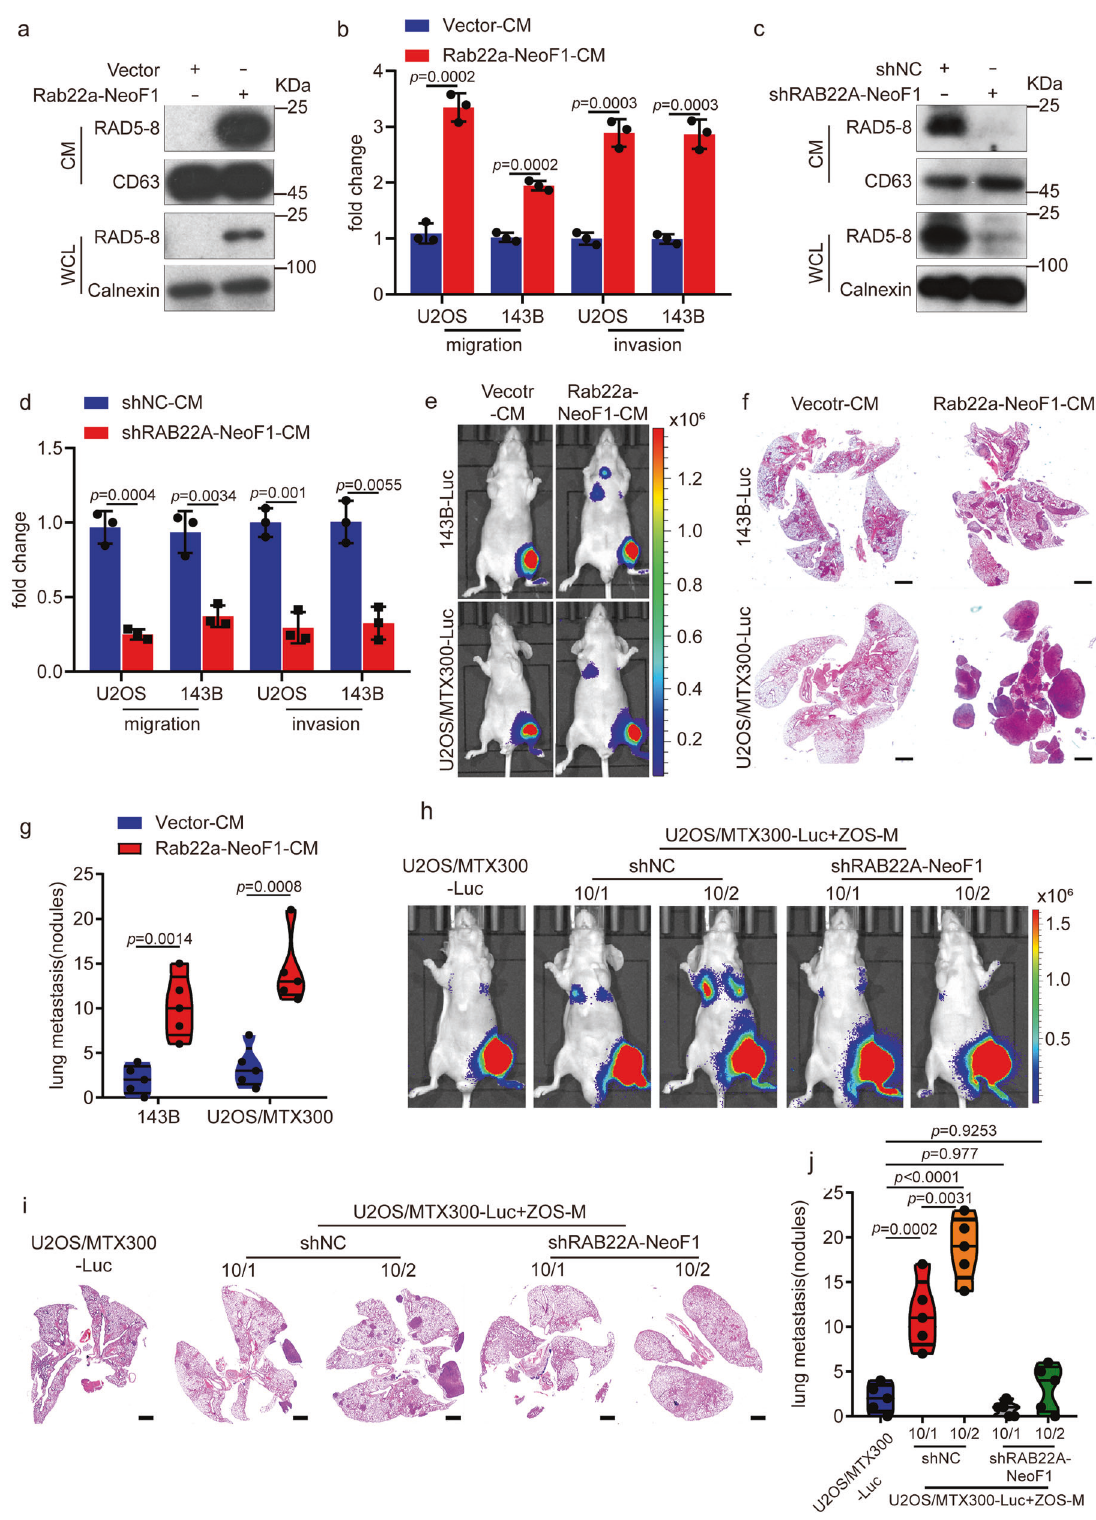
U2OS and 143B cells that are negative for RAB22A -NeoF1 fusion gene (Fig. 1b). Consistently, the promotion of cell migration and invasion was signi fi cantly decreased in both U2OS and 143B cells treated with the CM derived from ZOS-M-sh RAB22A -NeoF1, ZOS-M cells knockdown endogenous RAB22A -NeoF1 using short hairpin Signal Transduction and Targeted Therapy (2021)